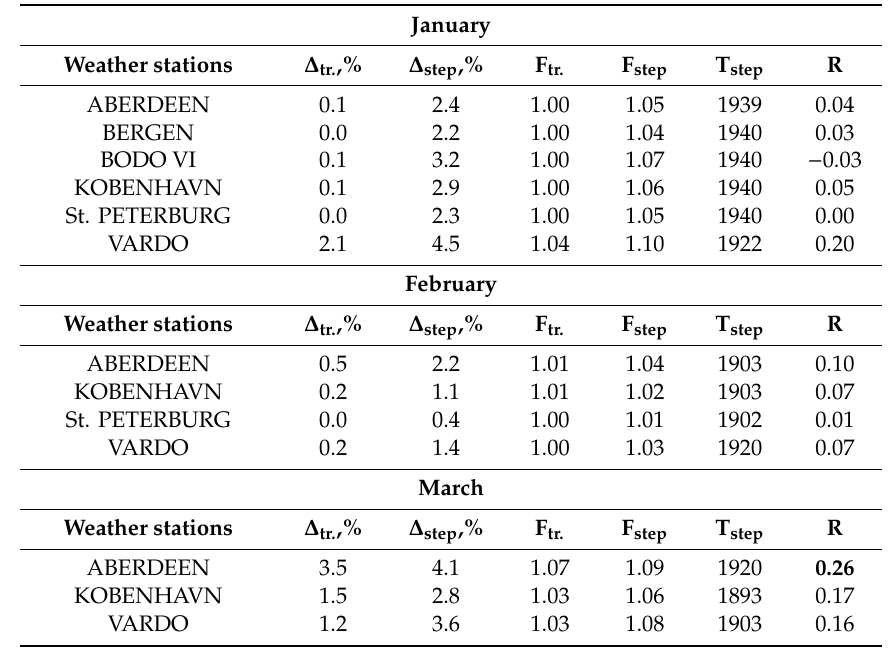
Table 8. The results of the e ffi ciency assessment of non-stationary models for the SAT time series at the weather stations in Northern Europe in January, February and March (1872–1950 period with the size of the time series n = 79). The bold font for R denotes statistically significant correlation coe ffi cients of linear trends for the whole